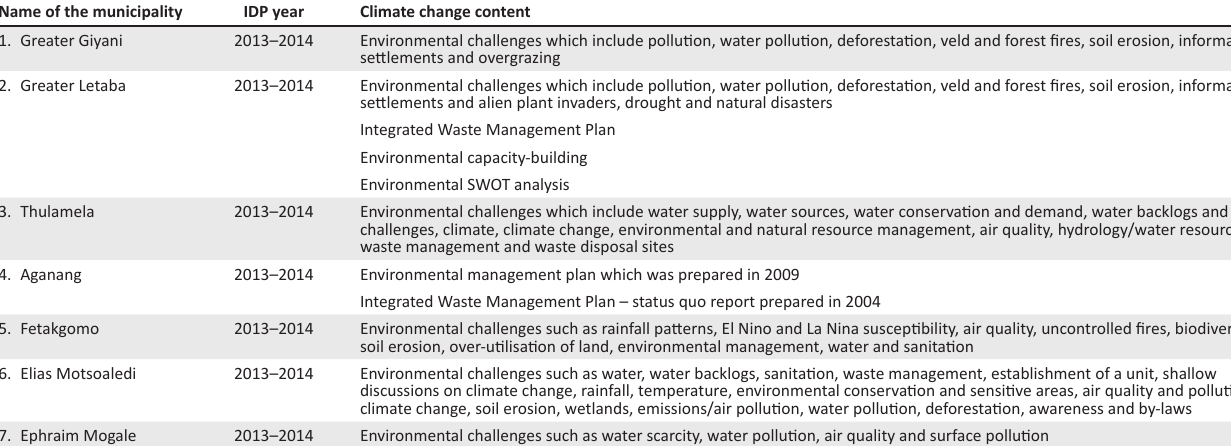
TABLE 3: Inclusion of climate change information in Integrated Development Plans. Name of the